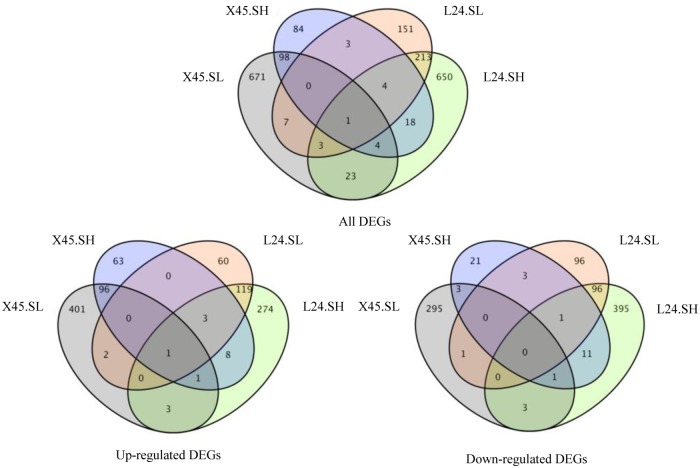
Venn diagram of the number of differentially expressed genes (DEGs) (log2>1.5) treated with salt stress in different cultivars compared with the controls.